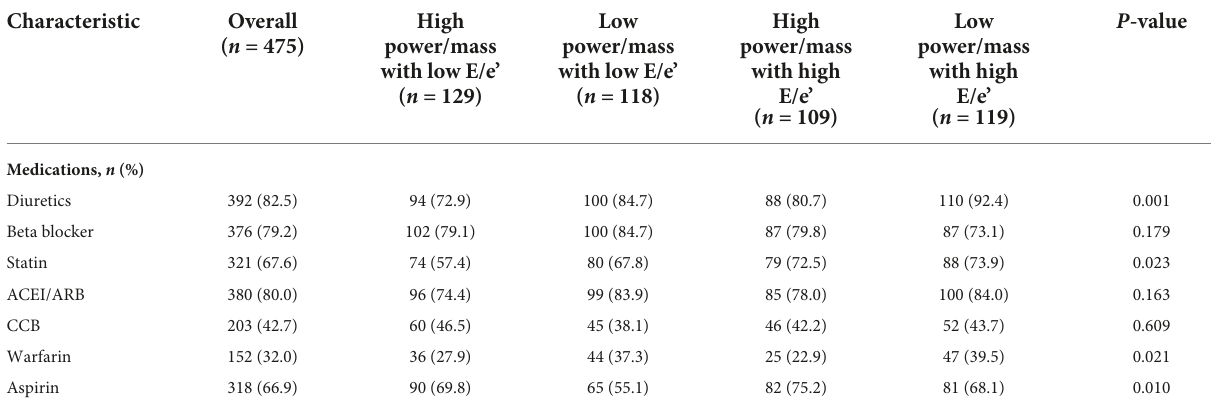
non-survivors for cardiovascular death did not reach statistical significance ( Supplementary Figure 1 ). Patients with low power/mass ( ≤ 0.362 W/100 g) experienced a higher risk of